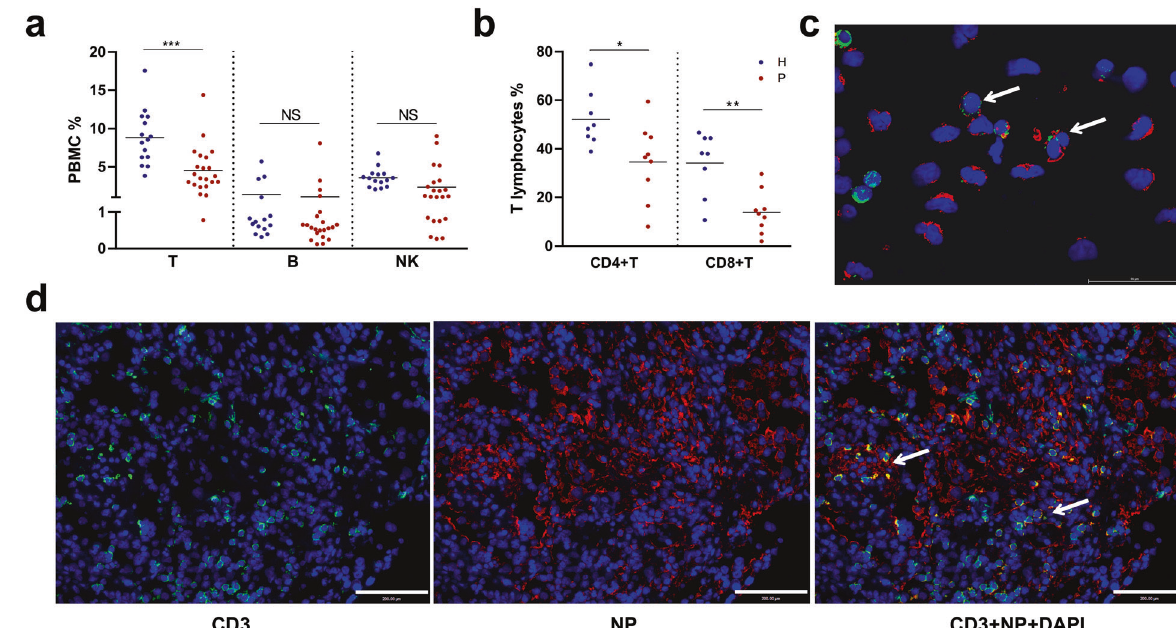
Fig. 1 Peripheral blood lymphocytes are infected by SARS-CoV-2 in COVID-19 patients. a Percentage of different types of lymphocytes in the healthy donors ( n = 15) or in COVID-19 patients ( n = 22). ( b ) Percentage of CD4 + and CD8 + T lymphocytes in healthy donor ( n = 8) or in COVID-19 patients ( n = 9). c , d Immuno fl uorescent test of the presence of SARS-CoV-2 viral antigen in T cells. PBCs ( c ) or postmortem lung section ( d ) from COVID-19 patients were stained with T lymphocytes (CD3, green), SARS-CoV-2 (NP, red) and nuclei (DAPI, blue). In-house- made pAb against SARS-CoV-2 NP was used. White arrows indicate areas T lymphocytes that were infected by SARS-CoV-2. Pictures were taken under confocal microscopy with a bar = 50 μ m ( c ) or 200 μ m ( d ). Comparison of mean values ( a , b ) between two groups was analyzed by Student ’ s t test. * P < 0.05; ** P < 0.01; **** P < 0.0001; NS no signi fi